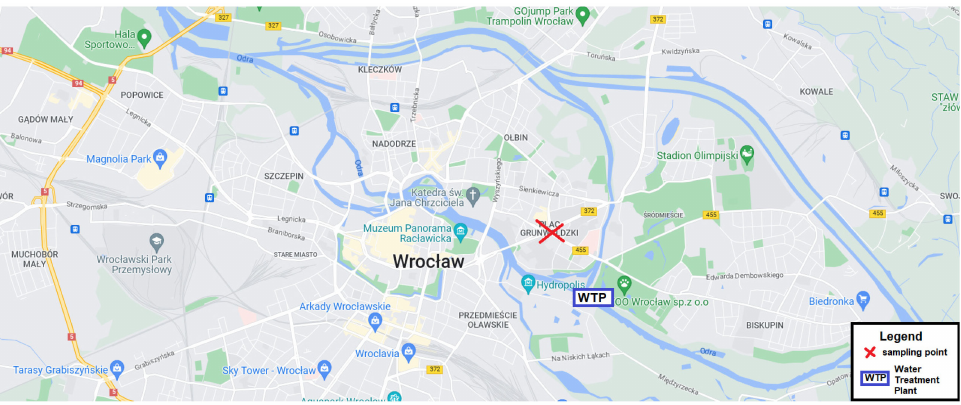
Figure 2. The location of the sampling point and the water treatment plant providing tap water (the distance of about 2 km), source: https://www.google.pl/maps, accessed on 20 January